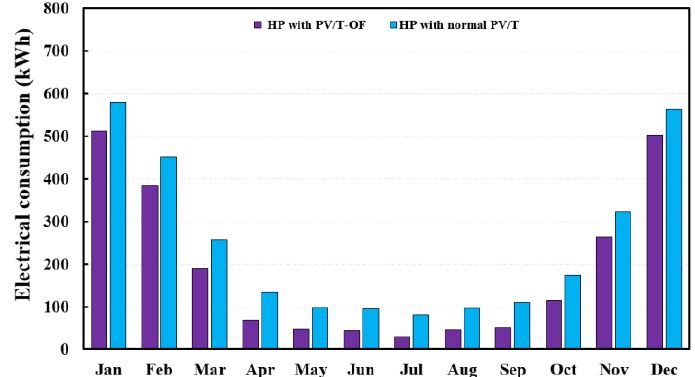
Figure 9. Electrical consumption of heat pump.